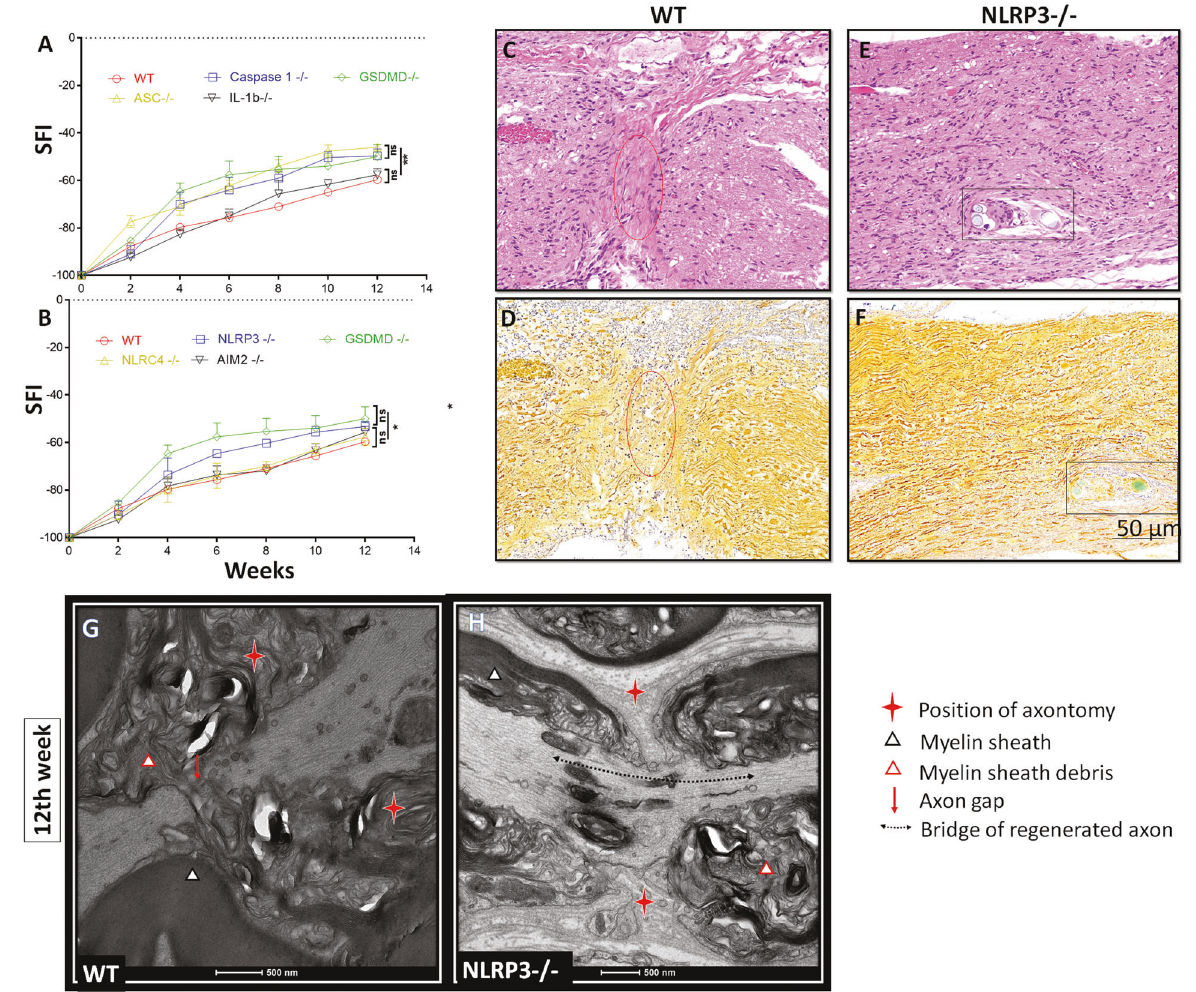
Fig. 3 The NLRP3 in fl ammasome rather than other in fl ammasomes or IL-1 β determined the PNR effects. A The GSDMD − / − , ASC − / − , and caspase-1 − / − mice had better recovery of the SFI than the WT and IL-1 β − / − mice ( n = 3). B The NLRP3 − / − mice had better recovery of the SFI than the NLRC4 − / − and AIM2 − / − mice; furthermore, the NLRP3 − / − mice had an SFI similar to that of the GSDMD − / − mice ( n = 3). C , D H&E and silver staining of a bridge of the WT SNTM group, in which a gap was found between the proximal and distant nerve stumps. This gap (red oval area), attributed to fi brosis, hampered axon regeneration and resulted in an unfavorable PNR. E , F H&E and silver staining of a bridge of the NLRP3 − / − SNTM group, in which both regenerated axons and their supporting cell nuclei had a parallel arrangement and favorable PNR. In addition, the rectangular area shows the residual sutures. G , H Transmission electron microscopy of longitudinal sections of the WT and NLRP3 − / − mice with SNTM. In the WT SNTM group, transmission electron microscopy also identi fi ed a gap (red arrow) between the proximal and distant nerve stumps, and this gap hampered axon regeneration, while a bridge of reconnected axons was found in the NLRP3 − / − SNTM group; the black dashed line indicates the course of axons. * p < 0.05; ** p < 0.01; *** p < 0.001; **** p < loop. Consistently, we also found that the macrophages in the WT SNTM group were mainly M1 cells, whereas GSDMD de fi ciency-